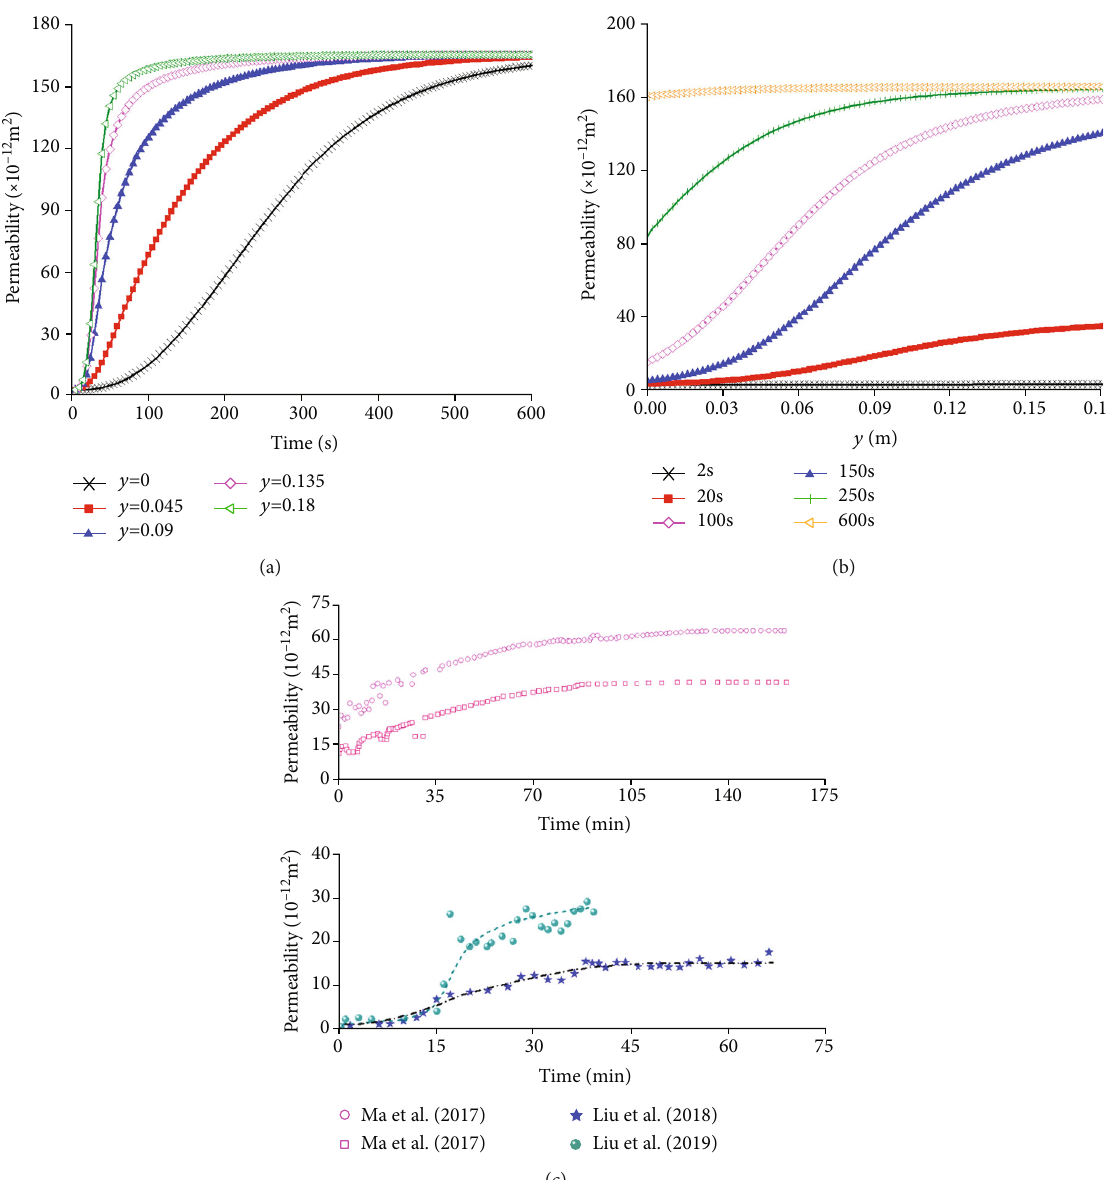
Figure 7: Evolution of permeability: (a) over time, (b) with space, and (c) experimental results from